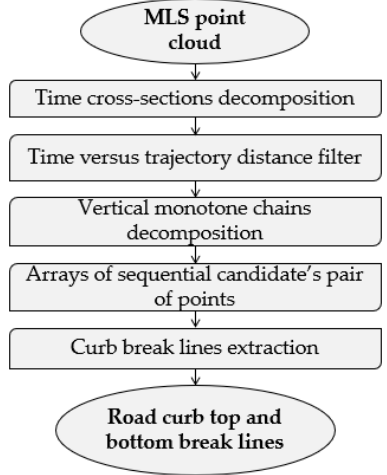
Figure 1. Flow chart of the proposed